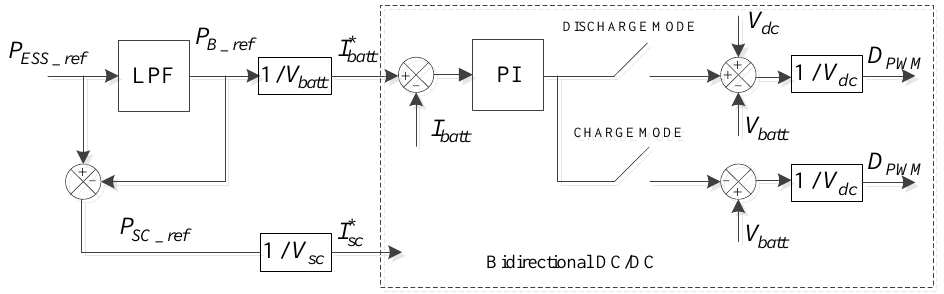
Figure 6. Control block diagram of a single distributed storage system with storage batteries.